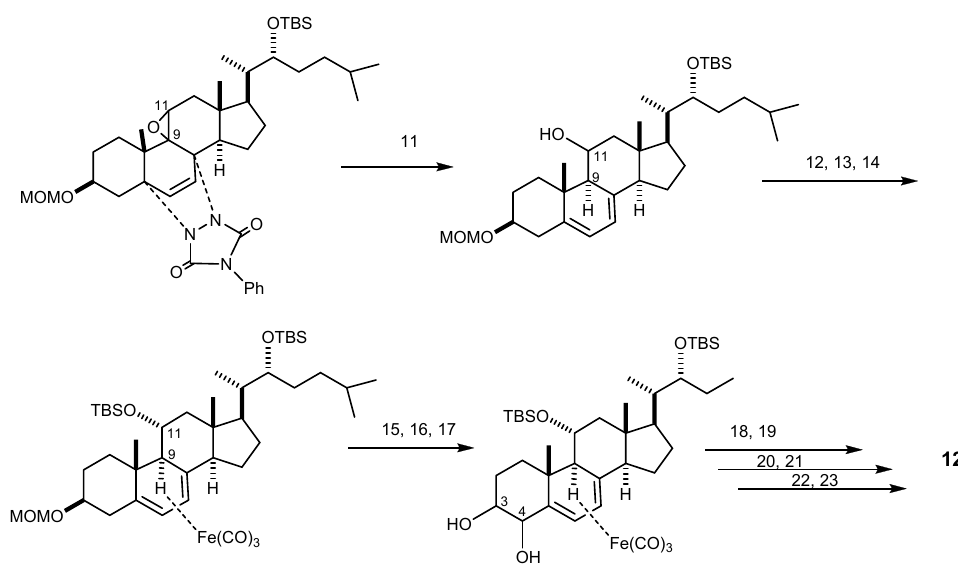
Scheme 2. The synthetic pathway of agosterol A ( 12 ). Reagents and conditions : (1) MOMCl, i Pr 2